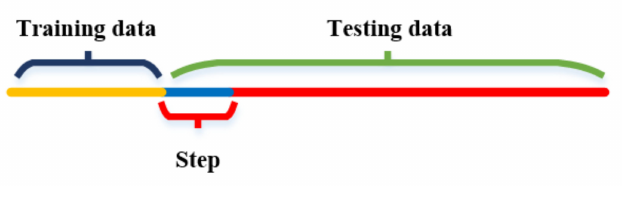
Figure 5. Data structure. Table 2. Specifications of Simple Recurrent Unit Recurrent Neural Networks